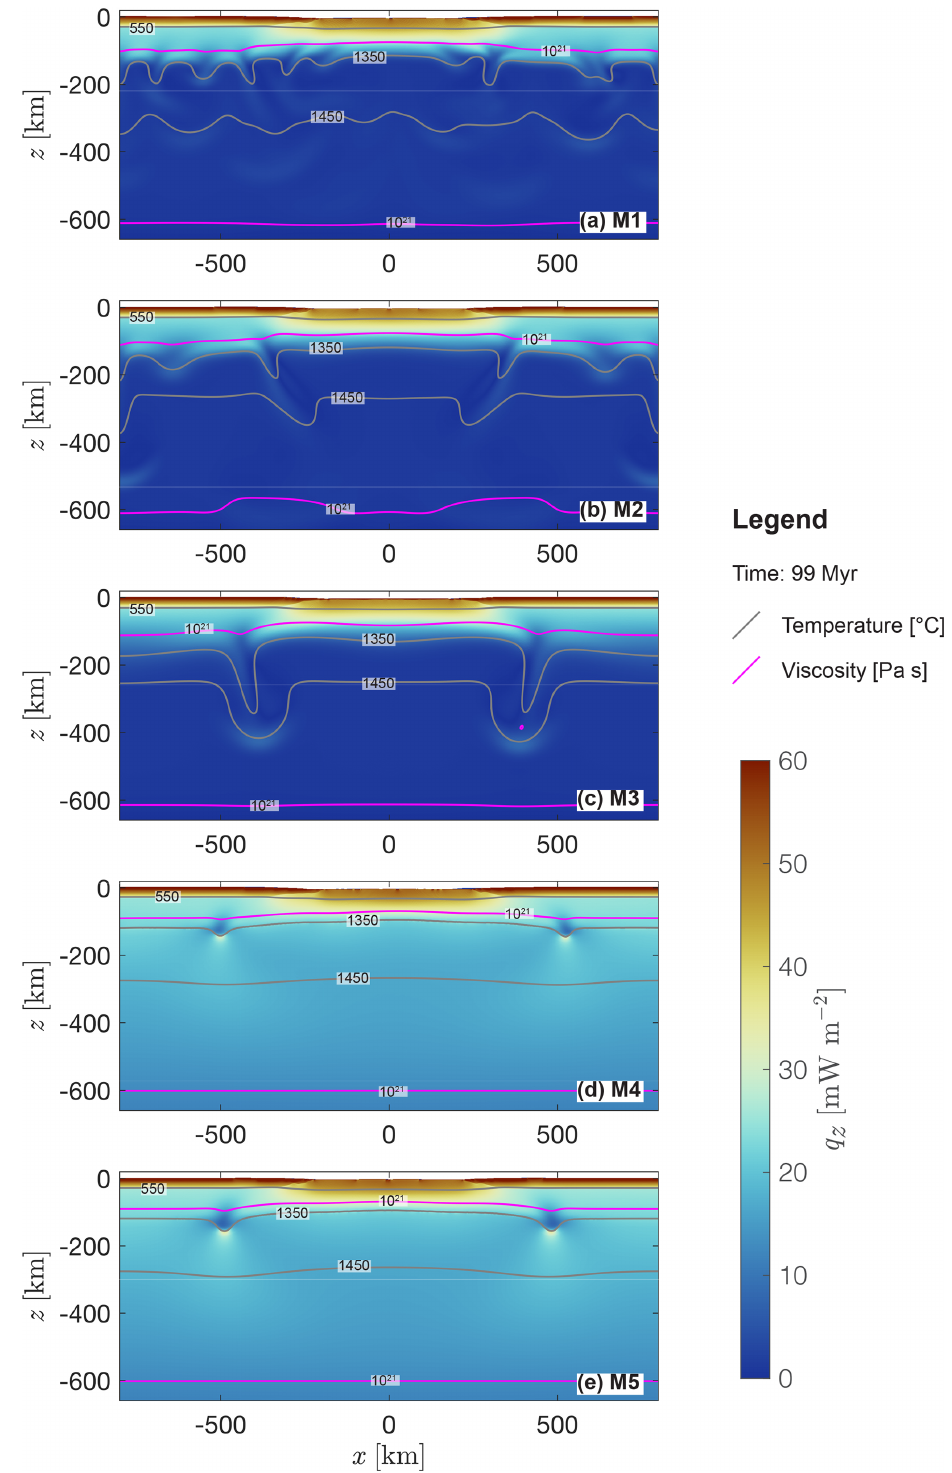
Figure 8. Vertical conductive heat flow represented by blue to red colours for models M1–5 (a–e) after 99Myr. The grey lines indicate the depth of the 550, 1350 and 1450 ◦ C isotherm. The magenta line indicates the depth of the 10 21 Pas isopleth, which approximately represents the mechanical transition between the mantle lithosphere and the convecting upper